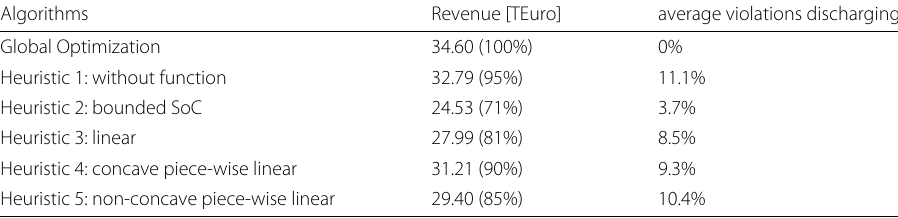
Table 3 Performance of one week simulation using different optimization frameworks Algorithms Revenue [TEuro] average violations discharging Global Optimization 34.60 (100%) 0% Heuristic 1: without function 32.79 (95%) 11.1% Heuristic 2: bounded SoC 24.53 (71%) 3.7% Heuristic 3: linear 27.99 (81%) 8.5% Heuristic 4: concave piece-wise linear 31.21 (90%) 9.3% Heuristic 5: non-concave piece-wise linear 29.40 (85%)